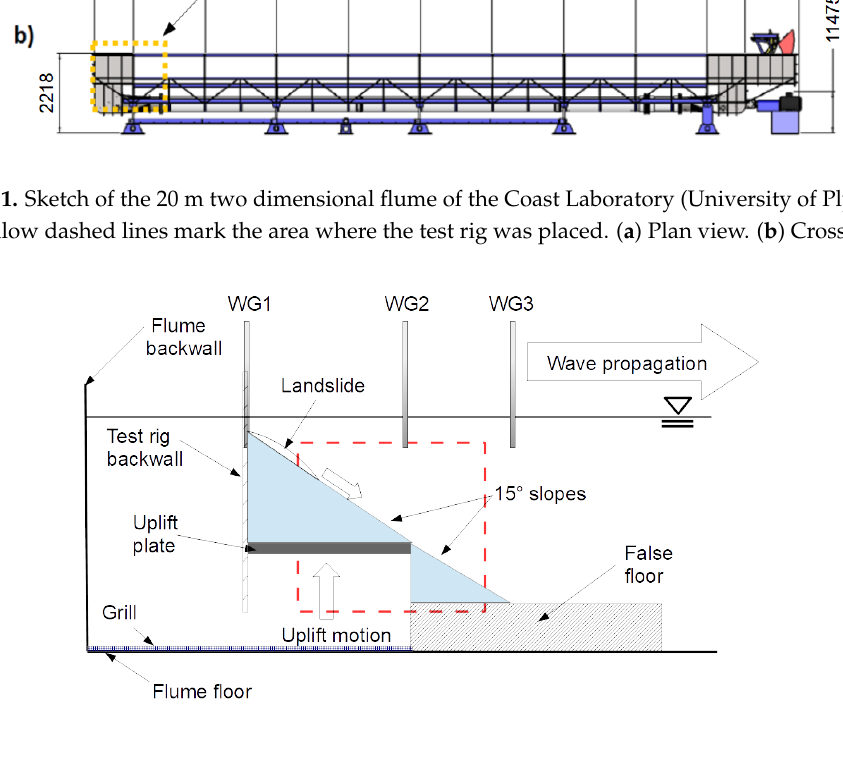
Figure 2. Schematic diagram (not to scale) of the test rig showing the fault rupture (uplift plate) and landslide model. WG indicates resistance wave gauges used to measure the surface elevation changes. The dashed red lines show the camera field of view.